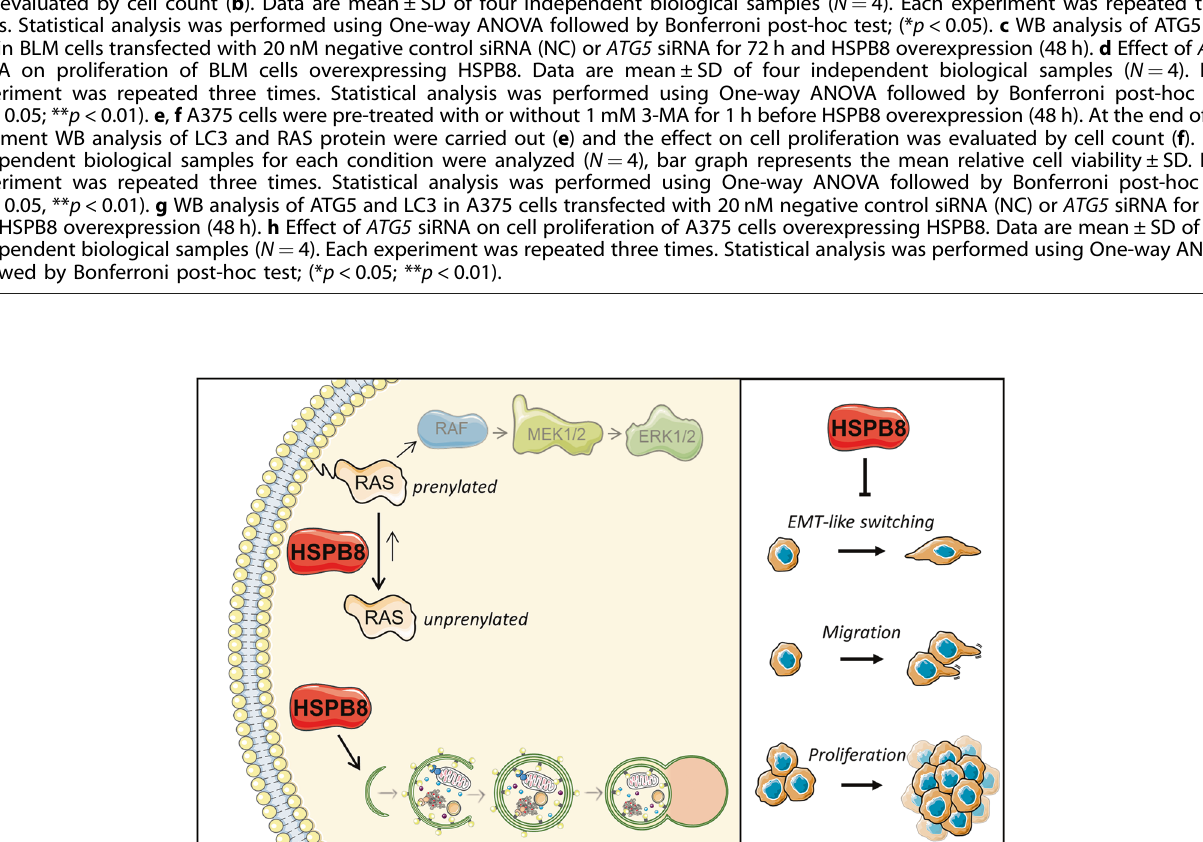
Fig. 7 Involvement of HSPB8-induced autophagy in BLM and A375 cell proliferation. a , b BLM cells were pre-treated with or without 1 mM 3-MA for 1 h before HSPB8 overexpression (48 h). WB analysis of LC3 and RAS protein were carried out ( a ) and the effect on cell proliferation